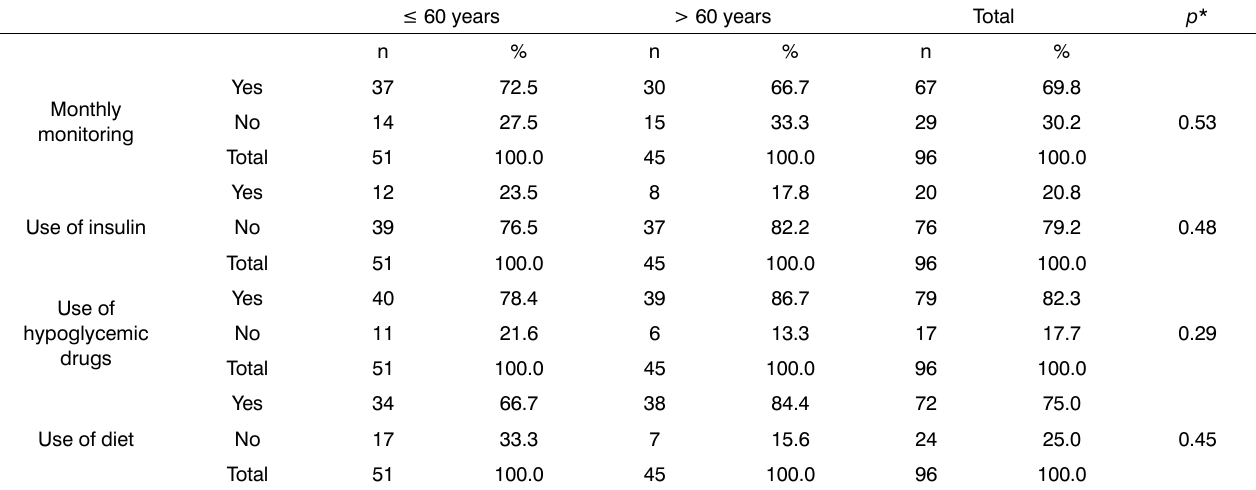
Table 3. Description of treatment variables in the group of diabetics (2009) ≤ 60 years > 60 years